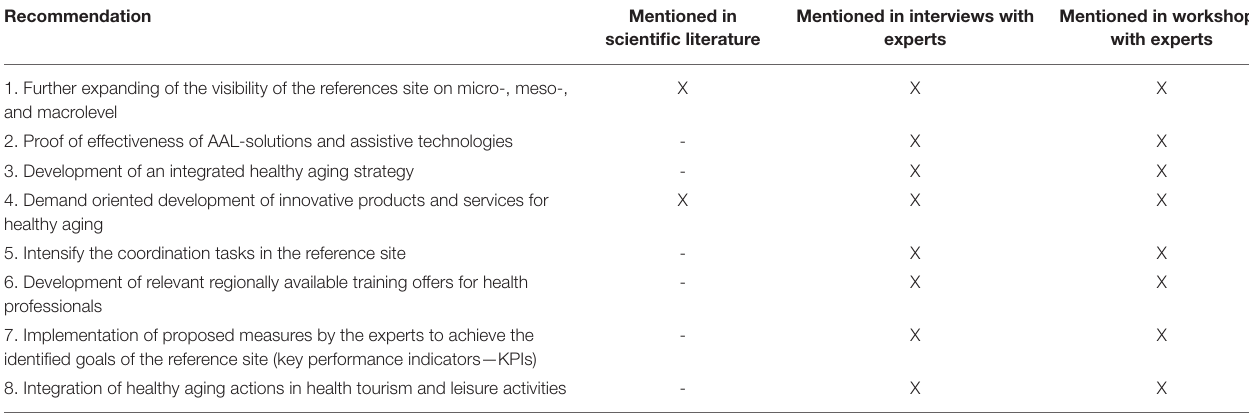
TABLE 1 | Recommendation for action toward an integrated ecosystem for AHA in Styria.